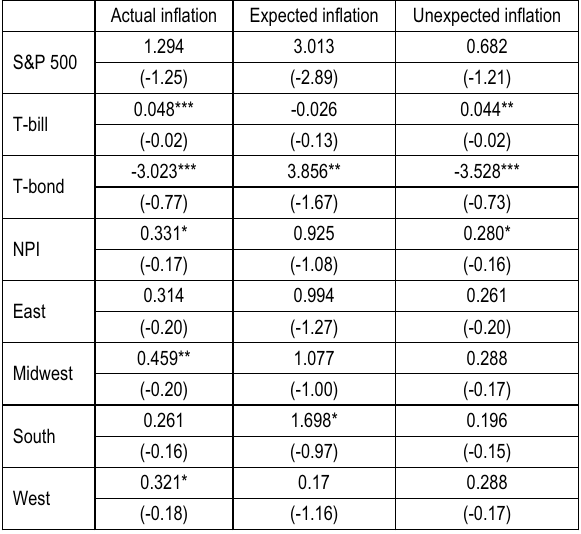
Table 4. Full sample